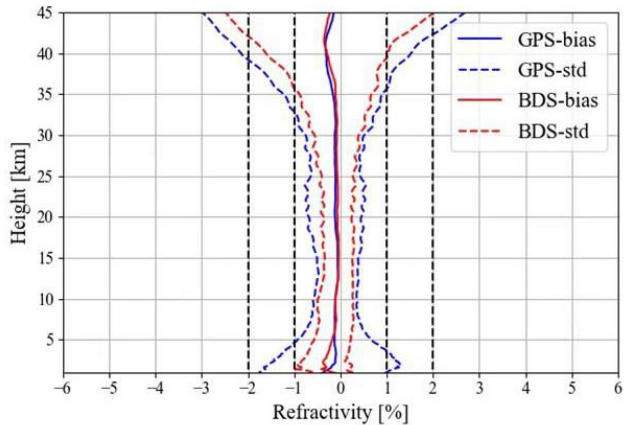
Figure 13. The inferred refractivity bias and standard deviation when atmospheric refractivity was calculated from the GNSS RO measurements of the GNOS-II against the NCEP FNL operational global analysis